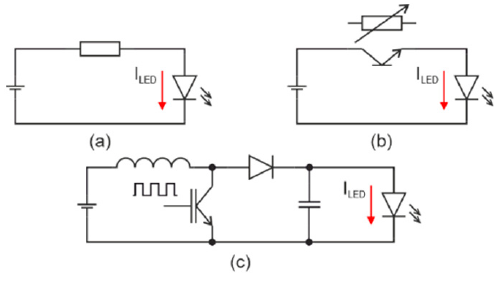
Figure 7. Basic principle of luminous flux drive ( a ) with resistor; ( b ) with transistor; and ( c ) DC/DC convertor (adapted from [5,33]).